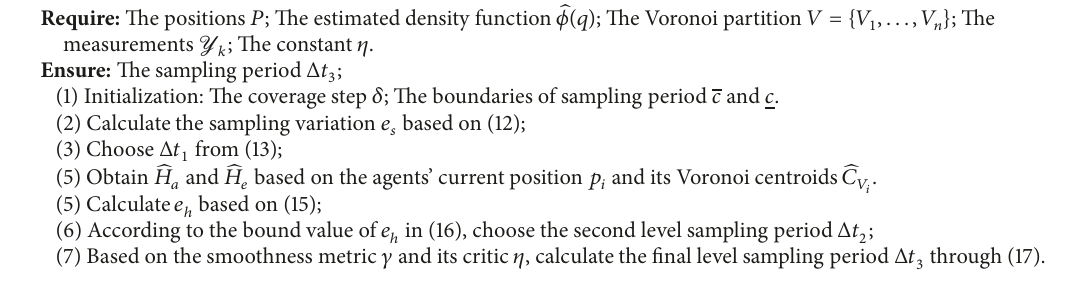
Algorithm 1: The sampling regulation mechanism in coverage